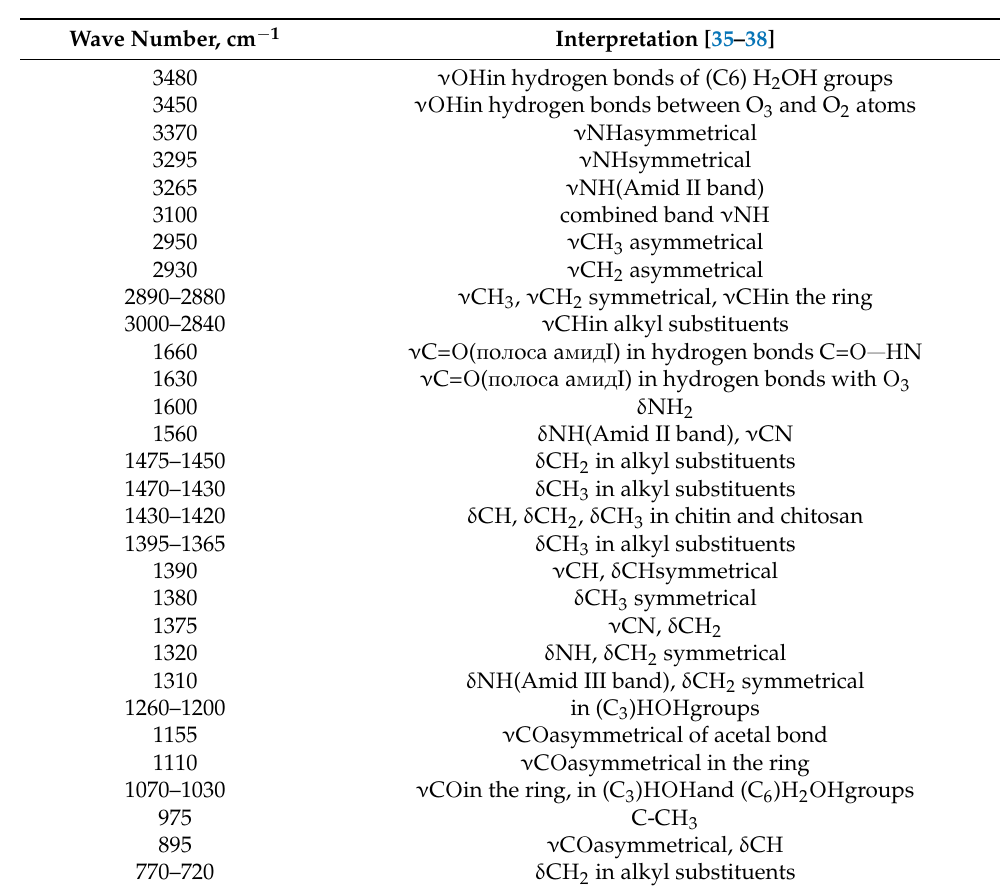
Figure 1. Chemical structure of chitosan. Table 2. Interpretation of IR spectra.